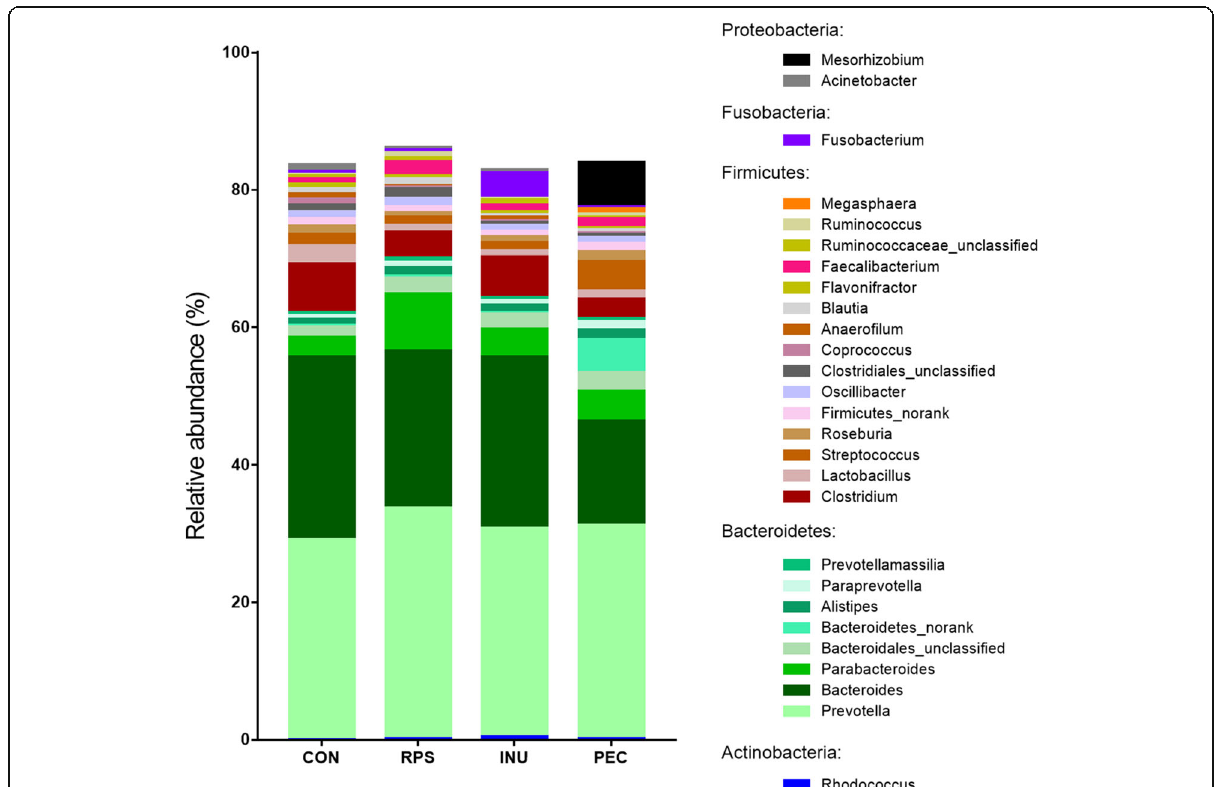
Fig. 3 Distribution of dominant genera of bacteria (more than 0.5%) in at least one group. CON, control diet; RPS, raw potato starch-enriched diet; INU, inulin-enriched diet; PEC, pectin-enriched